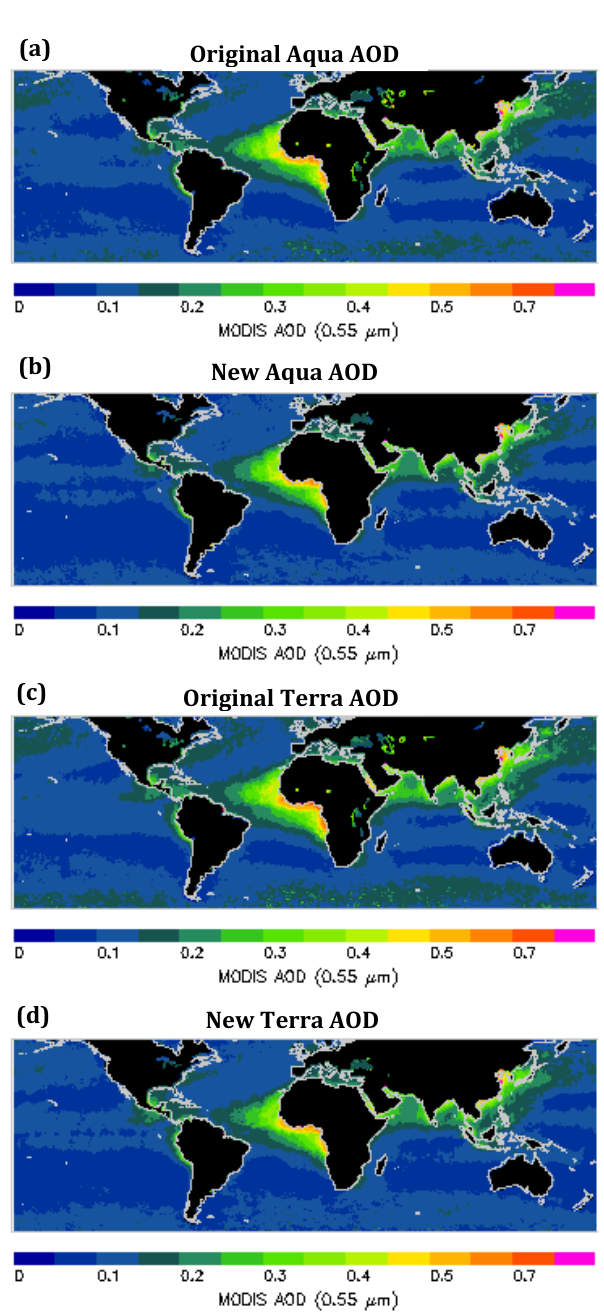
Fig. 6. Spatial distribution of AOD at 0.55µm from the MODIS C5 aerosol products. Black color represents land, blue color represents areas with low AOD loadings, and pink color indicates areas with extreme high AOD values. (a) for the original Aqua MODIS data. (b) As in (a) but for the newly generated Aqua AOD. (c) and (d) As in (a) and (b) but for Terra